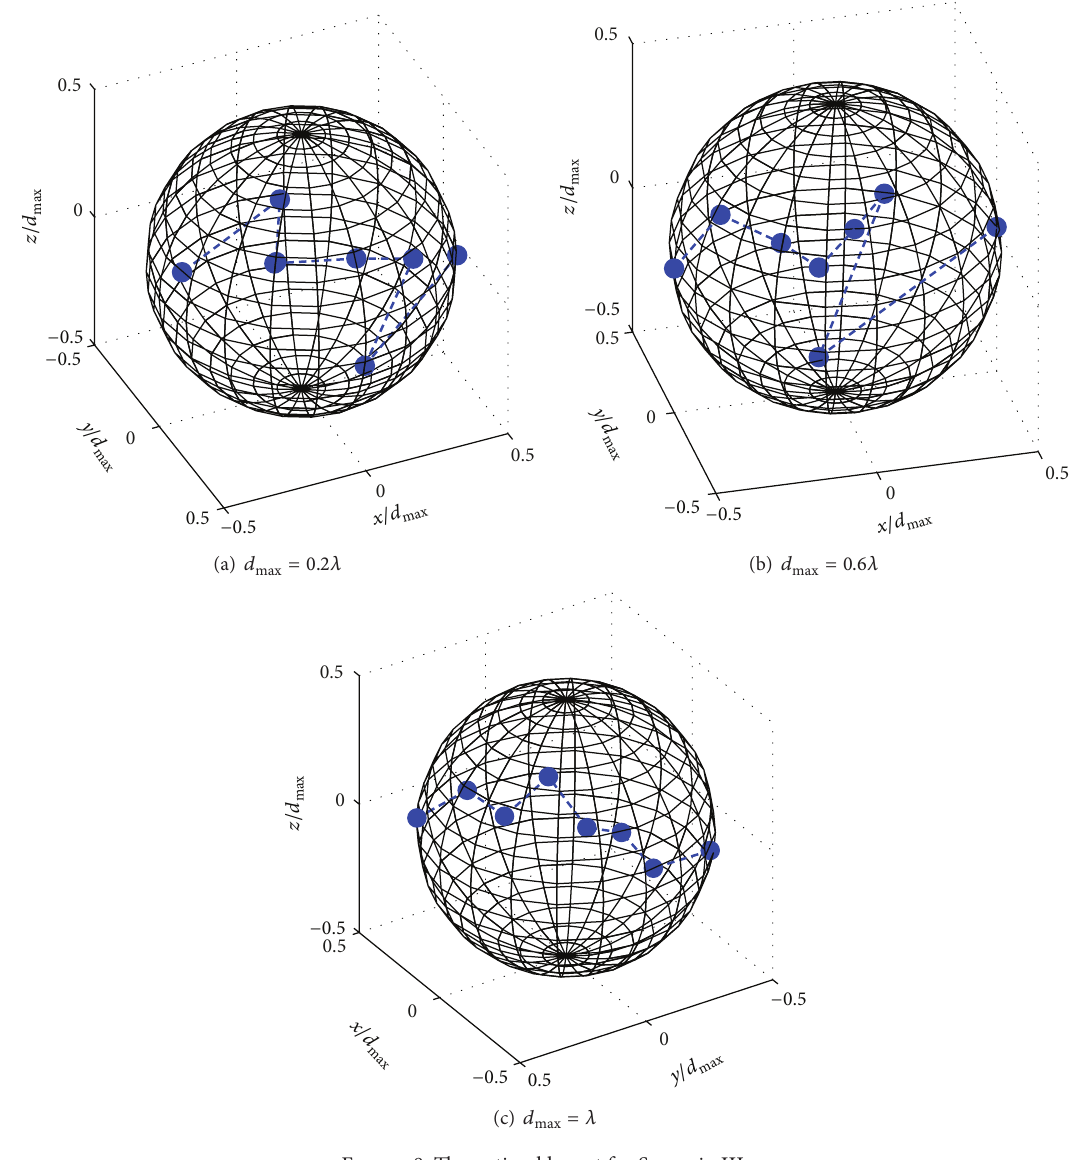
Figure 8: The optimal layout for Scenario